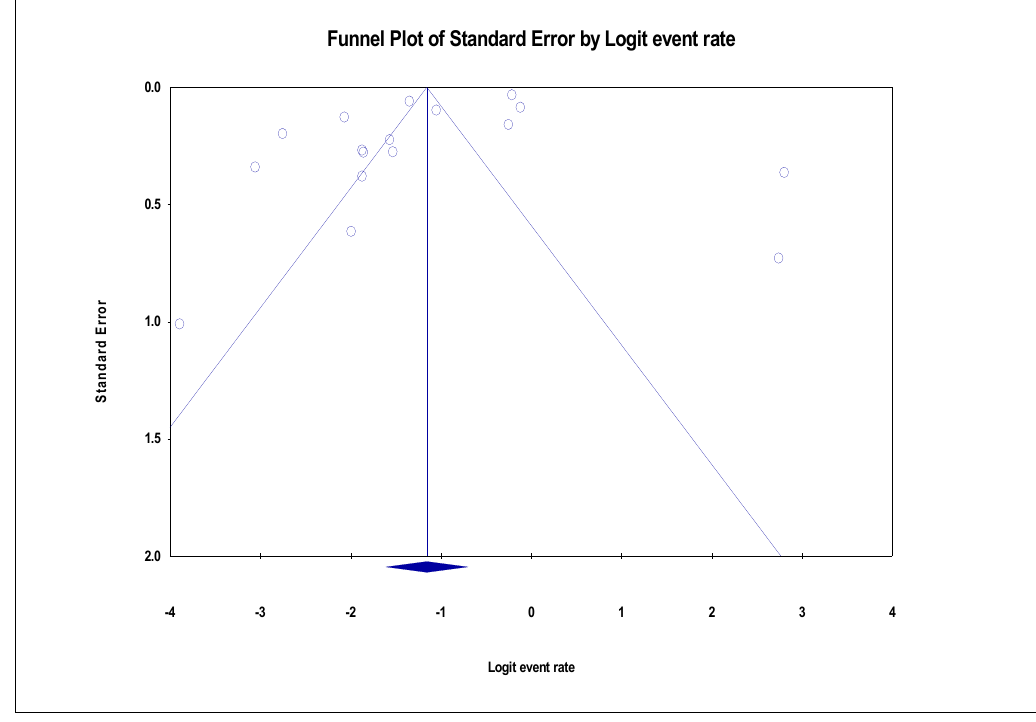
Figure 3. Leave-one-out forest plot of VRE in poultry in Malaysia.